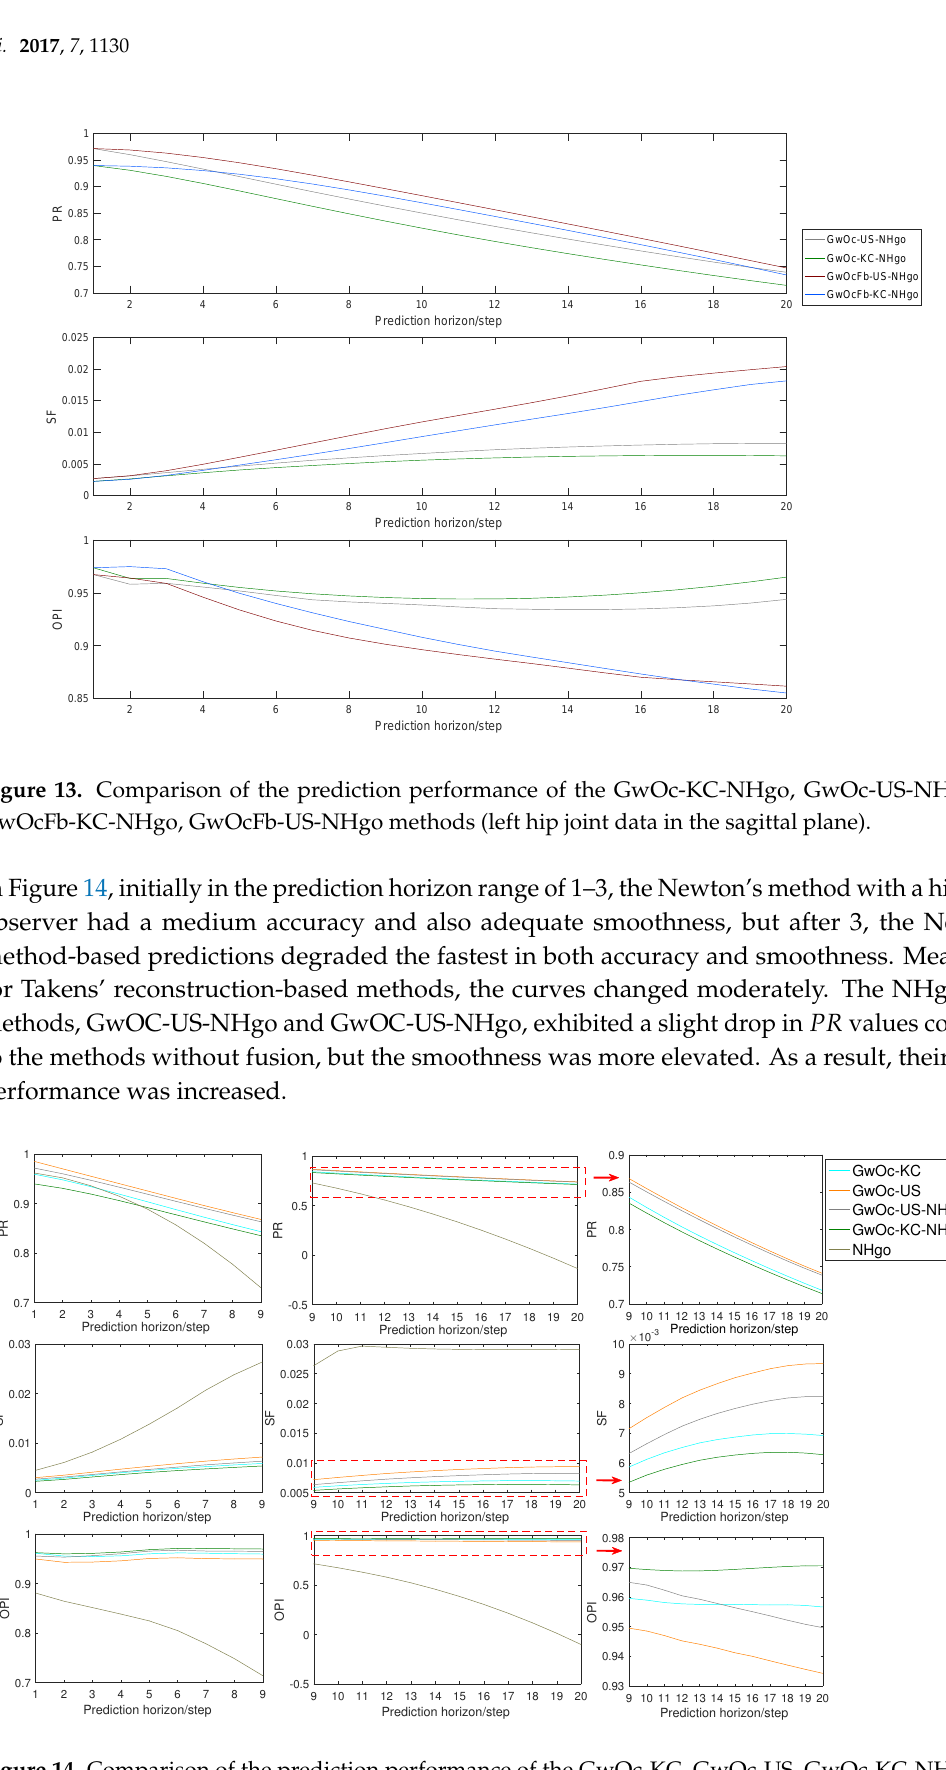
Figure 14. Comparison of the prediction performance of the GwOc-KC, GwOc-US, GwOc-KC-NHgo, GwOc-US-NHgo, and NHgo methods (left hip joint data in the sagittal